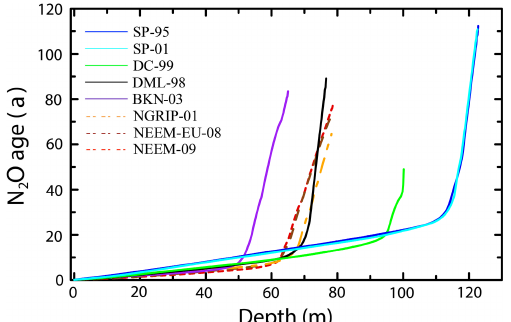
Figure 1. N 2 O mean ages in firn vs. depth. The dashed lines rep- resent the sites from the NH (North Greenland Ice-core Project (NGRIP-01 Bernard ), North Eemian Ice-core Project (NEEM-09, NEEM-EU-08)), and the solid lines the SH sites (South Pole (SP-01, SP-95), Dome C (DC-99), Dronning Maud Land (DML- 98), and Berkner Island (BKN-03)). The numbers accompanying the sites are the corresponding drilling years. Dashed orange line NGRIP-01, dashed brown NEEM-EU-08, dashed red NEEM-09, purple BKN-03, black DML-98, green DC-99, blue SP-95, and light blue